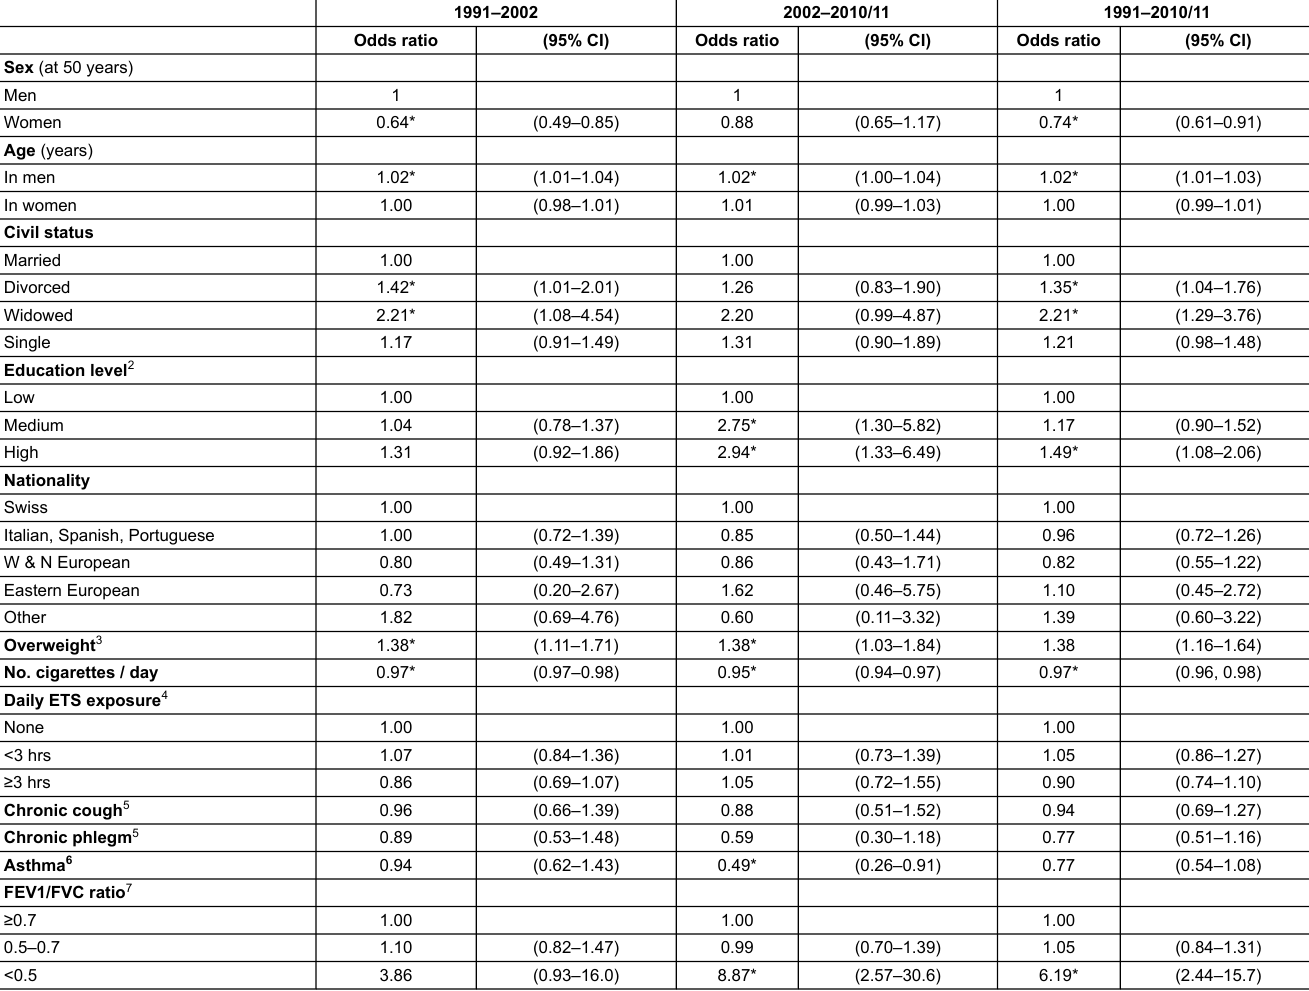
Table 2: Estimated independent associations of smoking cessation between surveys with different personal characteristics 1